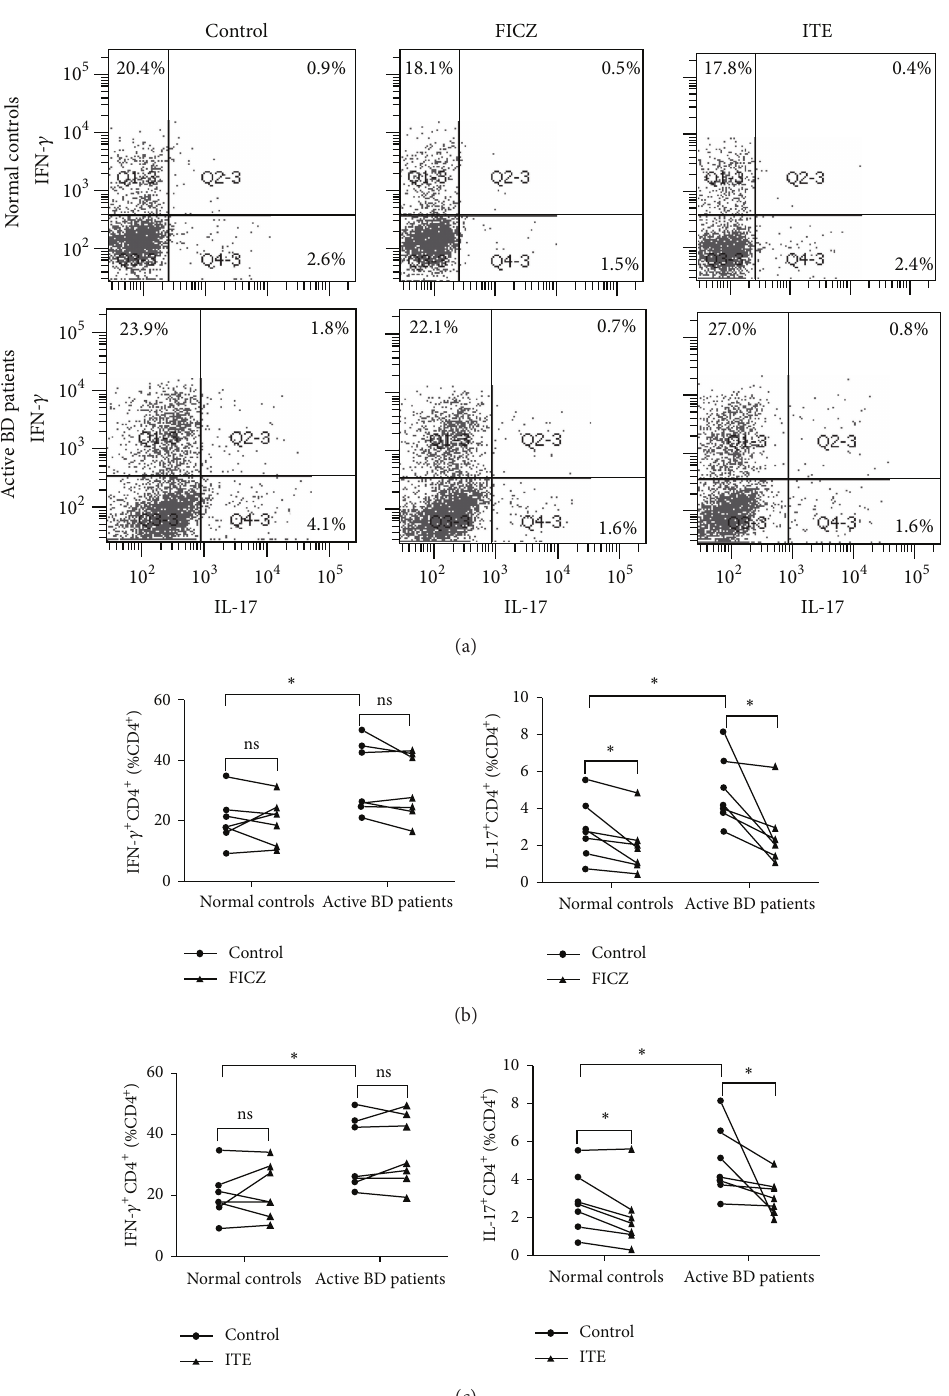
Figure 2: FICZ and ITE inhibit the frequency of IL-17-expressing CD4 + T cells but have no effect on IFN- 𝛾 -expressing CD4 + T cells in PBMCs. PBMCs from active BD patients ( 𝑛 = 7 ) and normal controls ( 𝑛 = 7 ) were stimulated with anti-CD3/CD28 in the presence or absence of FICZ (100nmol/L) or ITE (100nmol/L) for 3 days. The cells were analyzed for intracellular expression of IFN- 𝛾 and IL-17 by flow cytometry. (a) Dot plots of a representative subject for each group are shown. (b and c) Quantitative analysis of the percentage of IFN- 𝛾 - and IL-17-expressing CD4 + Tcells.Paired-sample t testorWilcoxon’smatched-pairstestforrelatedsamplesandIndependent-Sample t testforindependentsamples were used for statistical analyses. ∗ 𝑃 < 0.05 , ns: not statistically